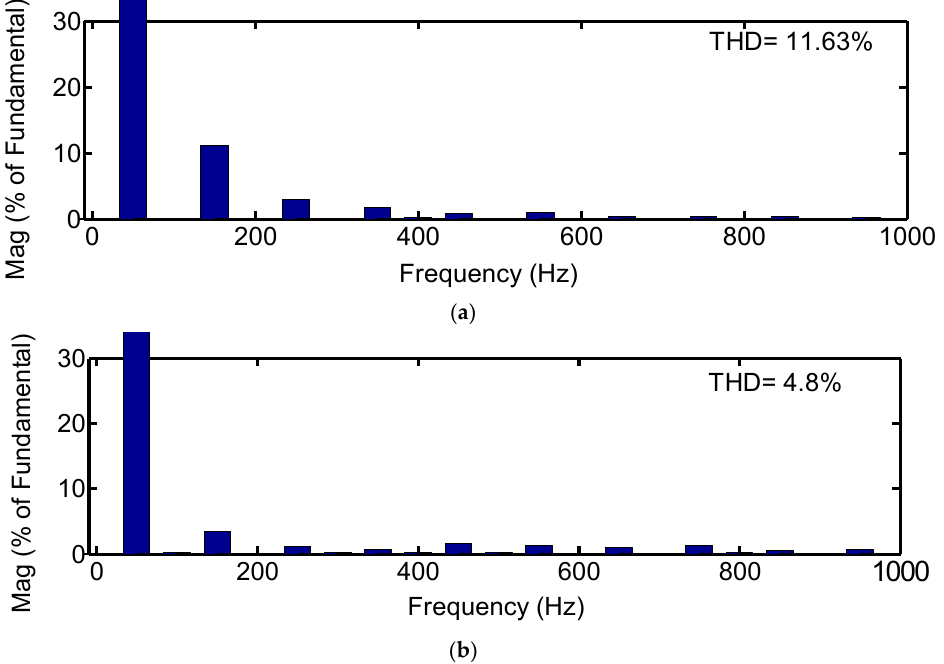
Figure 26 . Spectrum distribution of the output voltage under λ = 0.5 ( a ) Spectrum distribution of the output voltage for a traditional MMC. ( b ) Spectrum distribution of the output voltage for the proposed hybrid MMC.